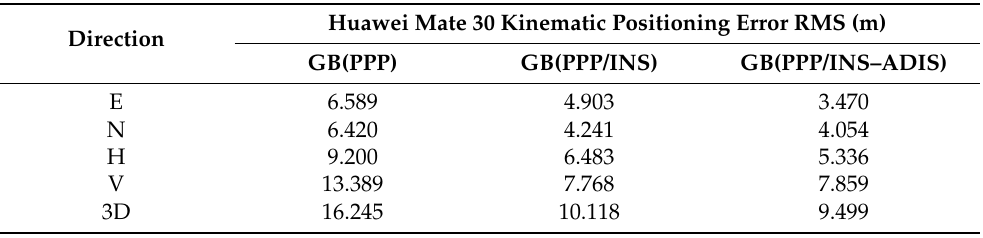
Table 3. RMS of GPS/BDS PPP and PPP/INS positioning errors using Huawei Mate 30 on the sidewalk.